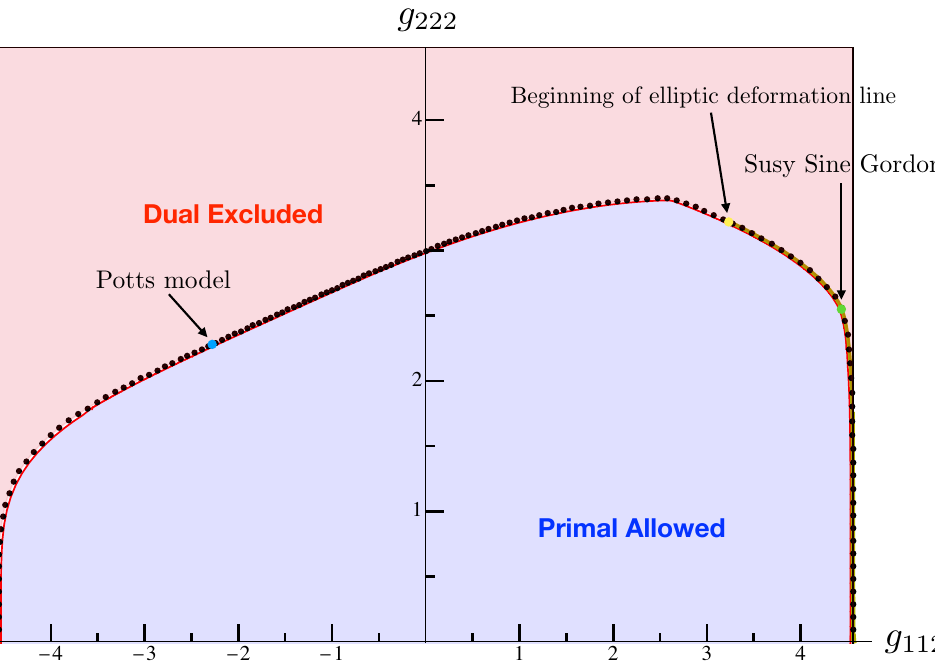
Figure 9 . Space of the Z 2 symmetric coupling constants { g 222 , g 112 } . We restrict to the UHP due to g ↔ − g symmetry. The black dots are obtained minimizing the objective in (D.18). The red solid line was obtained in [17] running the primal problem. The dual data have been obtained with very little effort: in this plot N max = 5 for all dual scattering functions ansatz. The blue and green dots mark respectively the well known integrable 3 -states Potts and supersymmetric Sine-Gordon. We recall that starting at θ = π/ 4 , the yellow dot, and all the way to θ = π/ 2 the S-matrix saturating the boundary is known analytically and correspond to the elliptic deformation of supersymmetric Sine-Gordon — see [17, 18] for